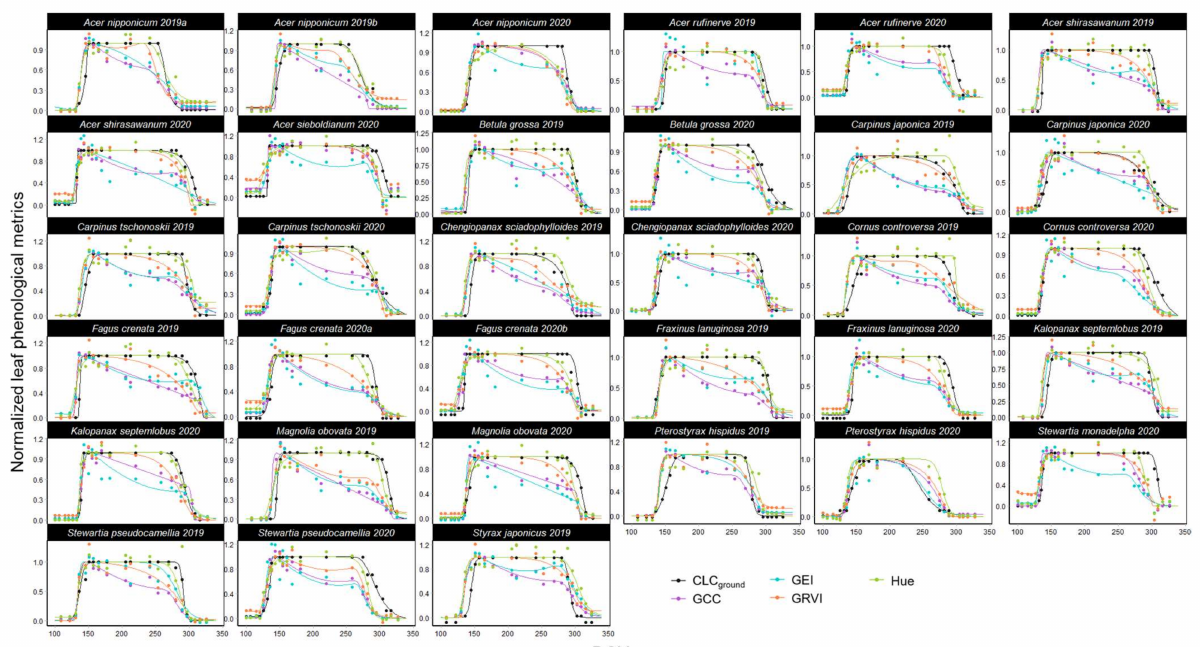
Figure A5. Time series of the leaf phenological metrics for all individual trees. Solid lines are fitted results of double logistic models. Fitted results are normalized to a scale from 0 to 1, and the scale of the phenological metrics was adjusted accordingly. Abbreviations: CLC ground , crown leaf cover based on the ground observation; GCC, green chromatic coordinate; GEI, green excess index; GRVI, green-red vegetation index; DOY, day of the year.